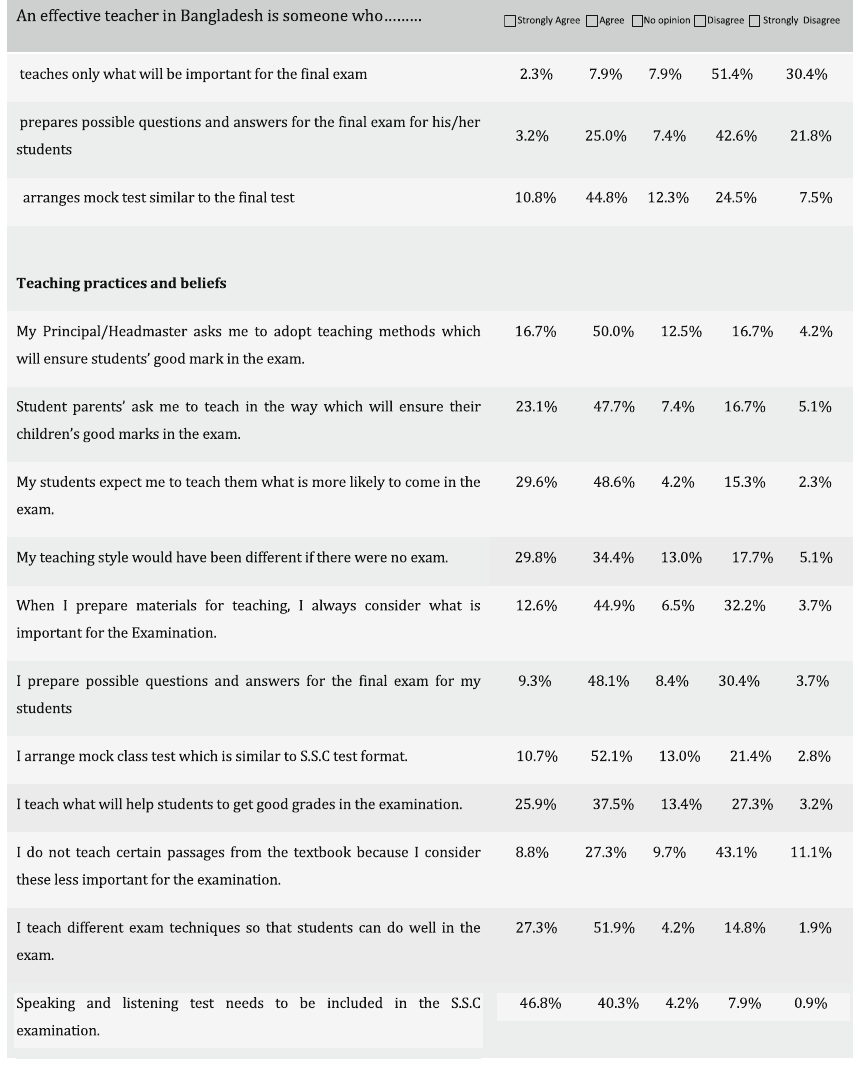
Table 1 Teachers ’ beliefs and practice about teaching for the